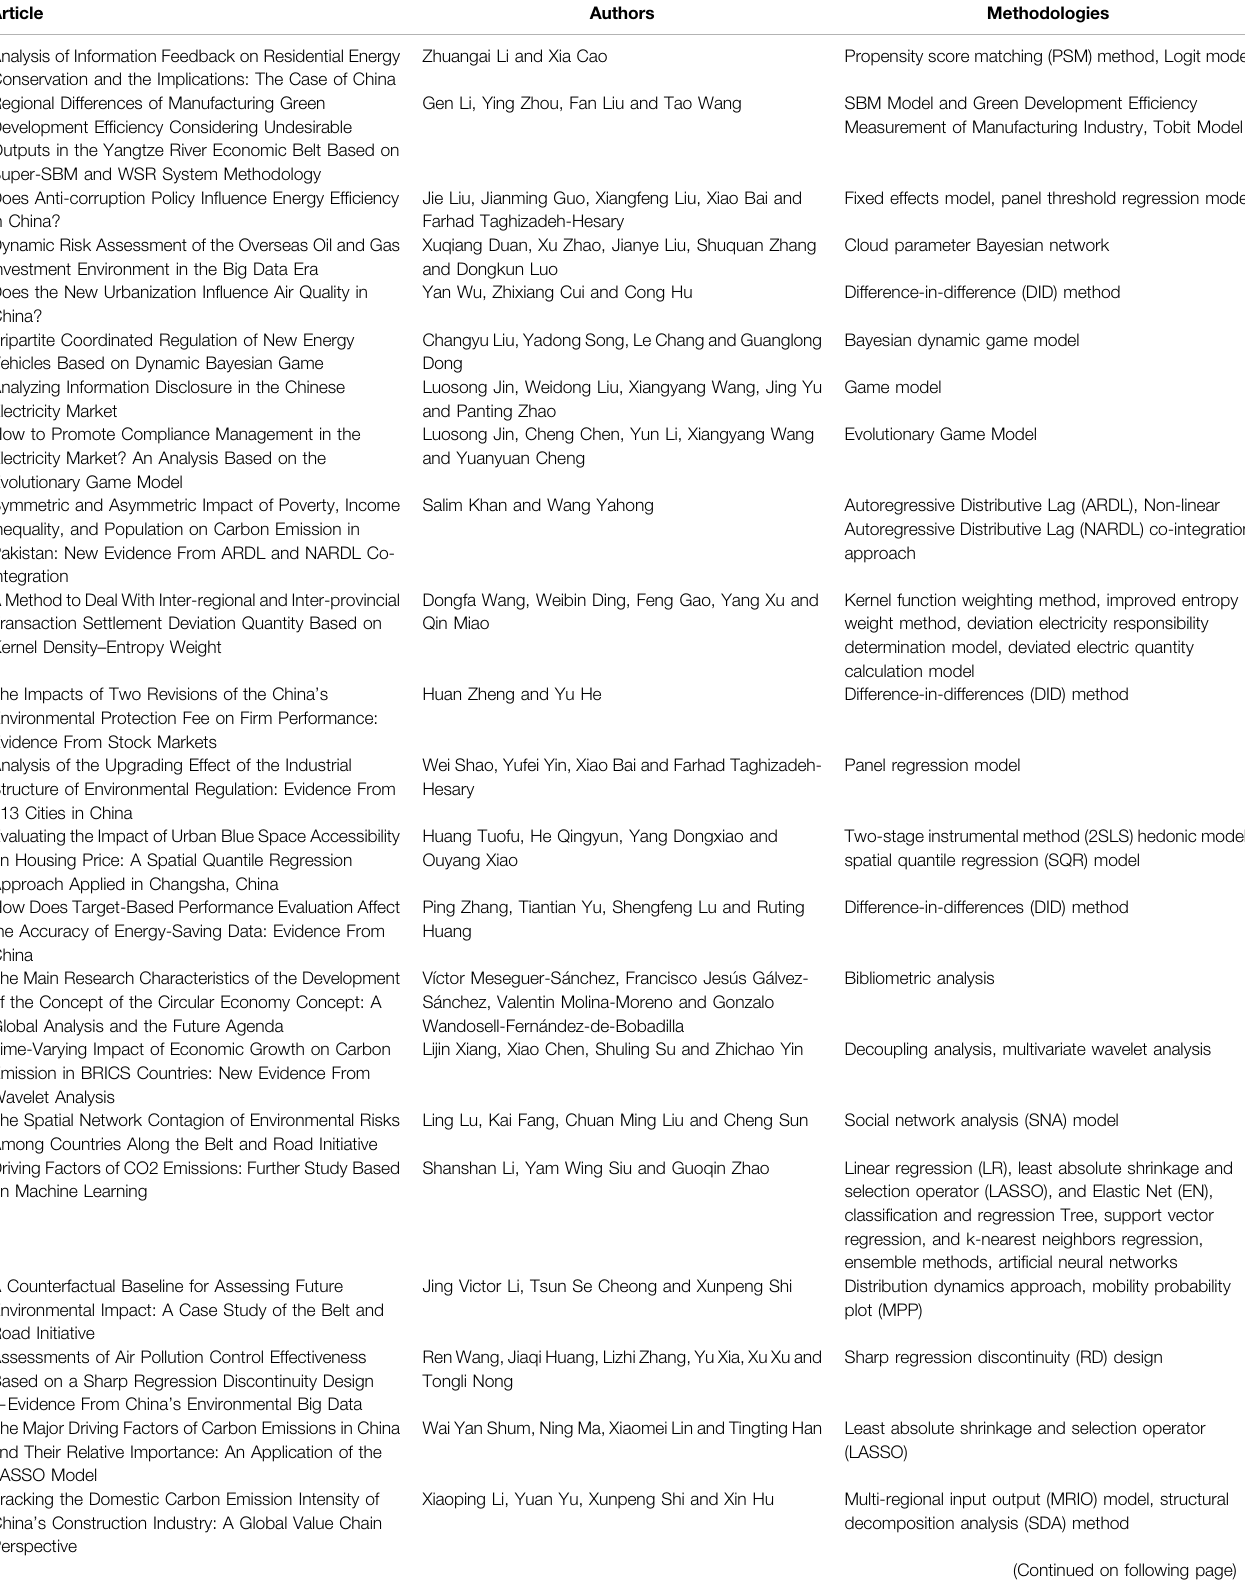
TABLE 1 | Summary of the methodologies employed in the